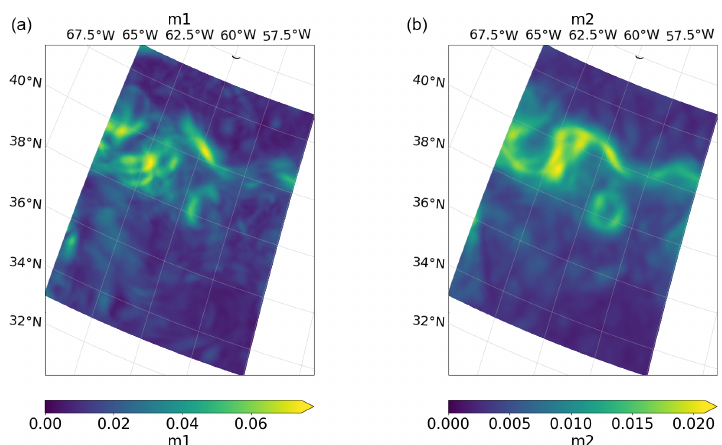
Figure 13. Standard deviation of the 4DVarNet-SSH median ensemble interpolation error (a) and average of the daily standard deviation interpolation errors in the test period (b)